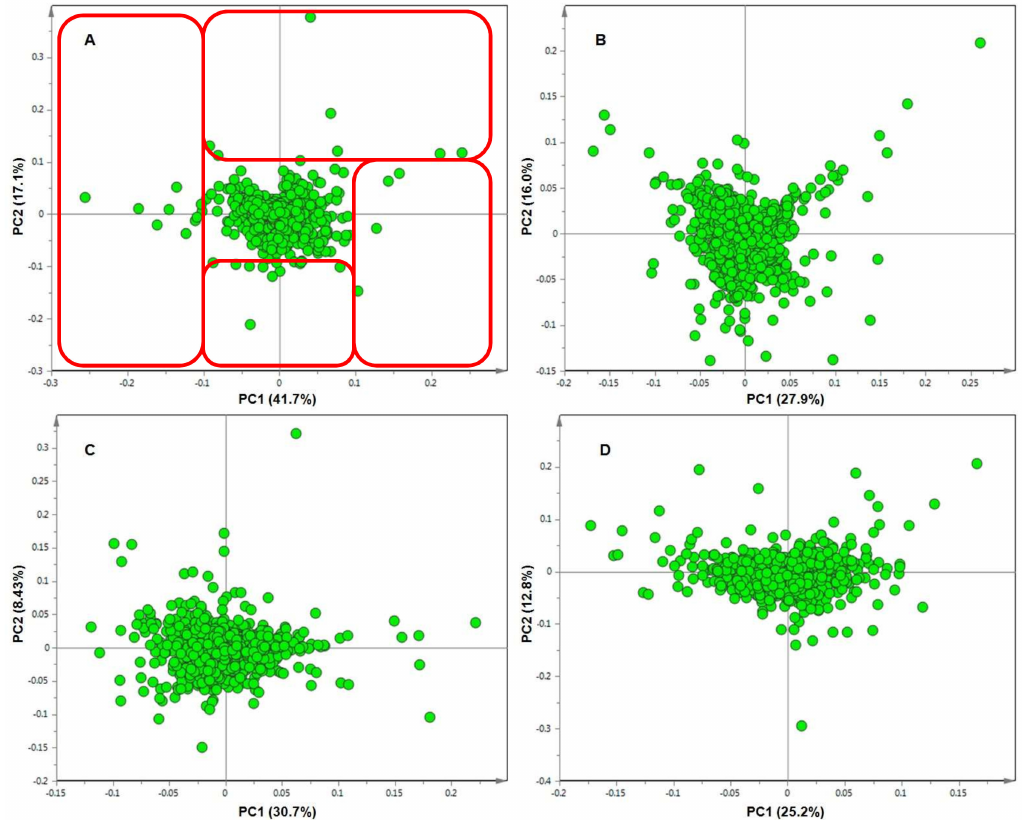
Figure 4. Principal component analysis (PCA) loadings plots of negative ionisation data for the resistant ( RT ) tomato plants. Shown are the metabolites (or biomarkers) responsible for the di ff erential clustering (highlighted in the red boxes) seen on the scores plots of the di ff erent treatment groups at ( A ) day 8, ( B ) day 15, ( C ) day 25 and ( D ) day